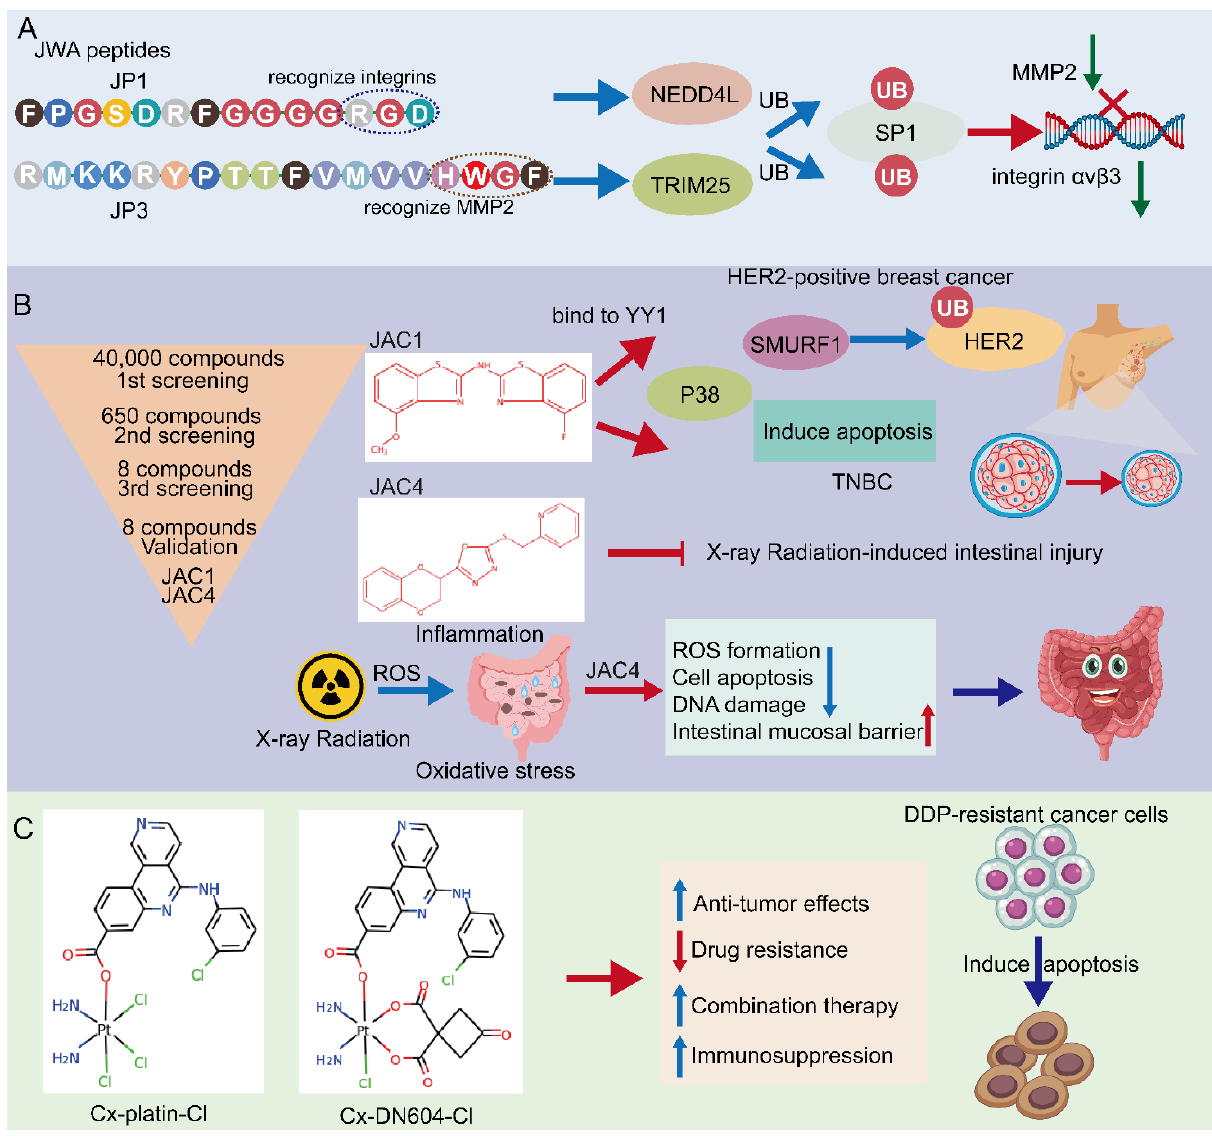
Figure 4. Potential approaches for JWA targeting in cancers. ( A ) Screening of JWA-targeted peptides: mechanistic study of anti-metastatic peptide JP1 and anti-angiogenetic peptide JP3. ( B ) Screening of JWA agonists: JAC1 has pro-apoptotic effect in HER2-positive breast cancer and TNBC. Moreover, JAC4 can attenuate X-ray radiation-induced intestinal epithelium injury by JWA-mediated anti-oxidation/inflammation signaling. ( C ) Emerging JWA-targeted Pt (IV) conjugated with CK2 inhibitor CX-4945: CX-platin-Cl and CX-DN604-Cl can overcome chemo-immune-resistance.